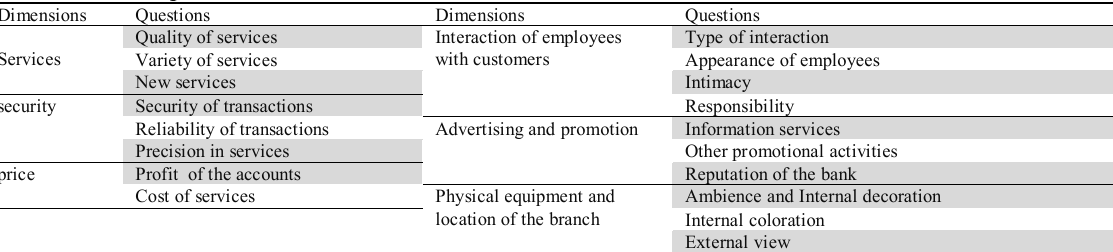
Dimensions and questions